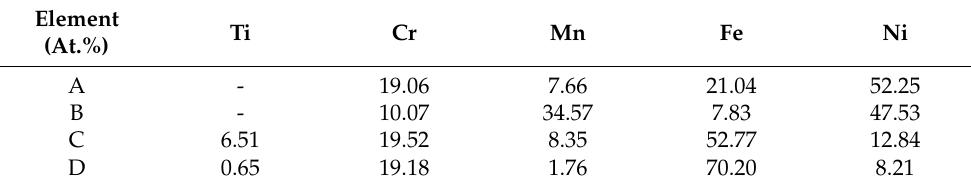
Figure 10. The SEM image and the corresponding element map distribution of brazing alloy on substrates of sandblasting + 4 μm Ni at 1170 °C/25 min. Table 6. The EDS results in Figure 10.